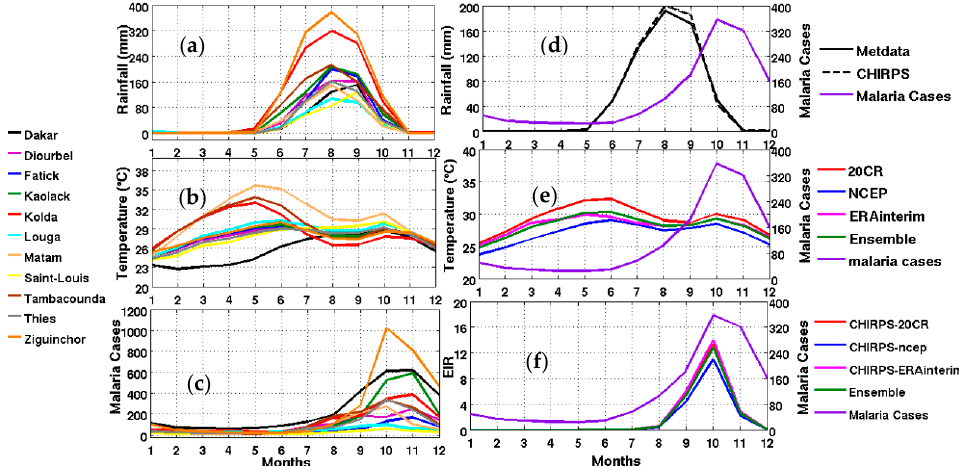
Figure 2. Left panel: ( a ) observed rainfall in mm; ( b ) averaged reanalysis temperature in °C (20th century reanalysis (20CR), NCEP, and ERA Interim); ( c ) mean annual cycle of observed malaria cases for different Senegalese stations from 2001 to 2010 corresponding to the common available period of observed rainfall and reanalyses data (20CR, NCEP, and ERA Interim and the ensemble mean of reanalyses); Right panel: Mean annual cycle of climate parameters, the simulated malaria parameter, and observed malaria cases: ( d ) rainfall; ( e ) temperature; ( f ) Entomological Inoculation Rate (EIR) (common period 2001–2010) and observed malaria cases in averaged Senegal stations (right y-axis for each figure).